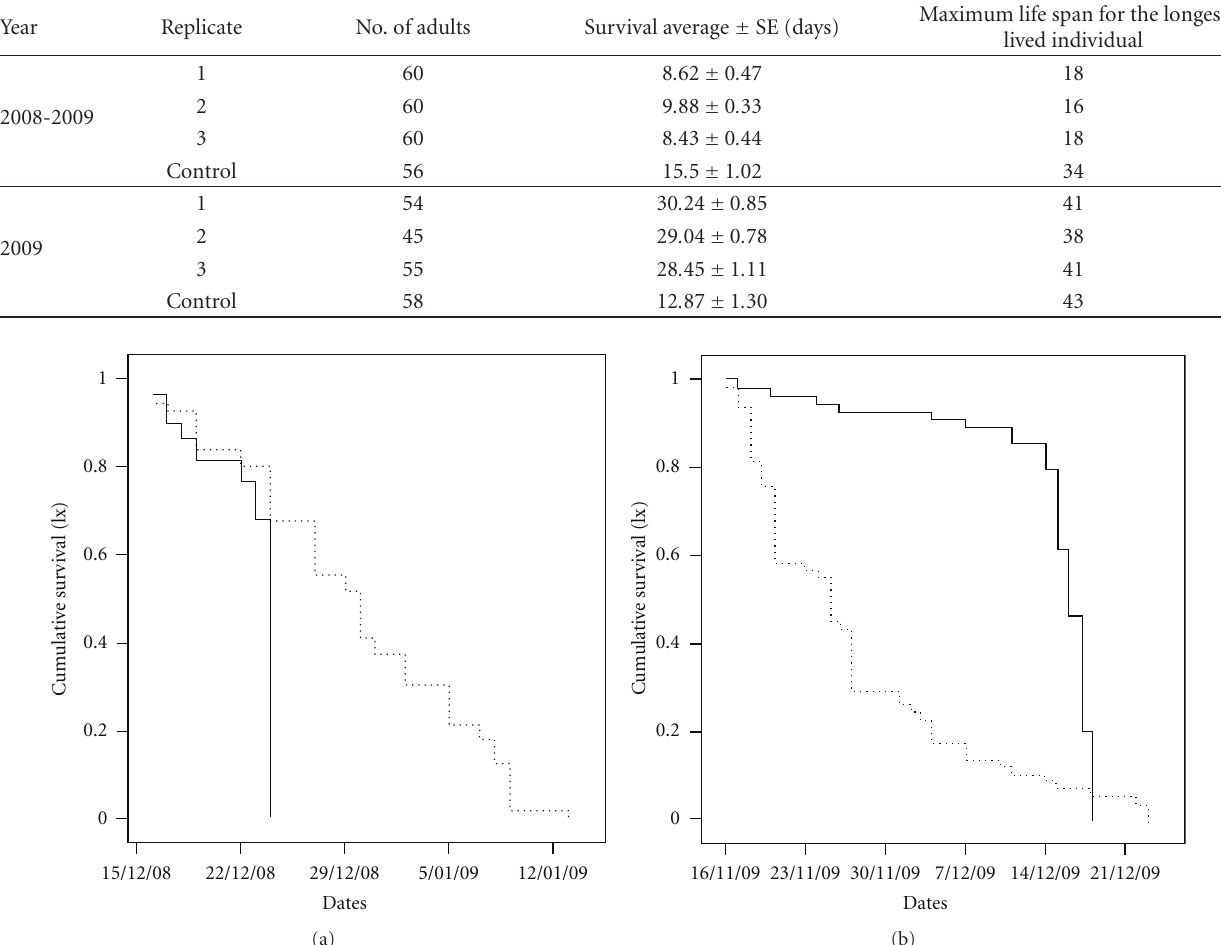
Table 1: Number of individuals, average survival rates, and maximum survival for Mediterranean fruit fly adults exposed in field conditions in December and November 2008 and 2009, respectively.